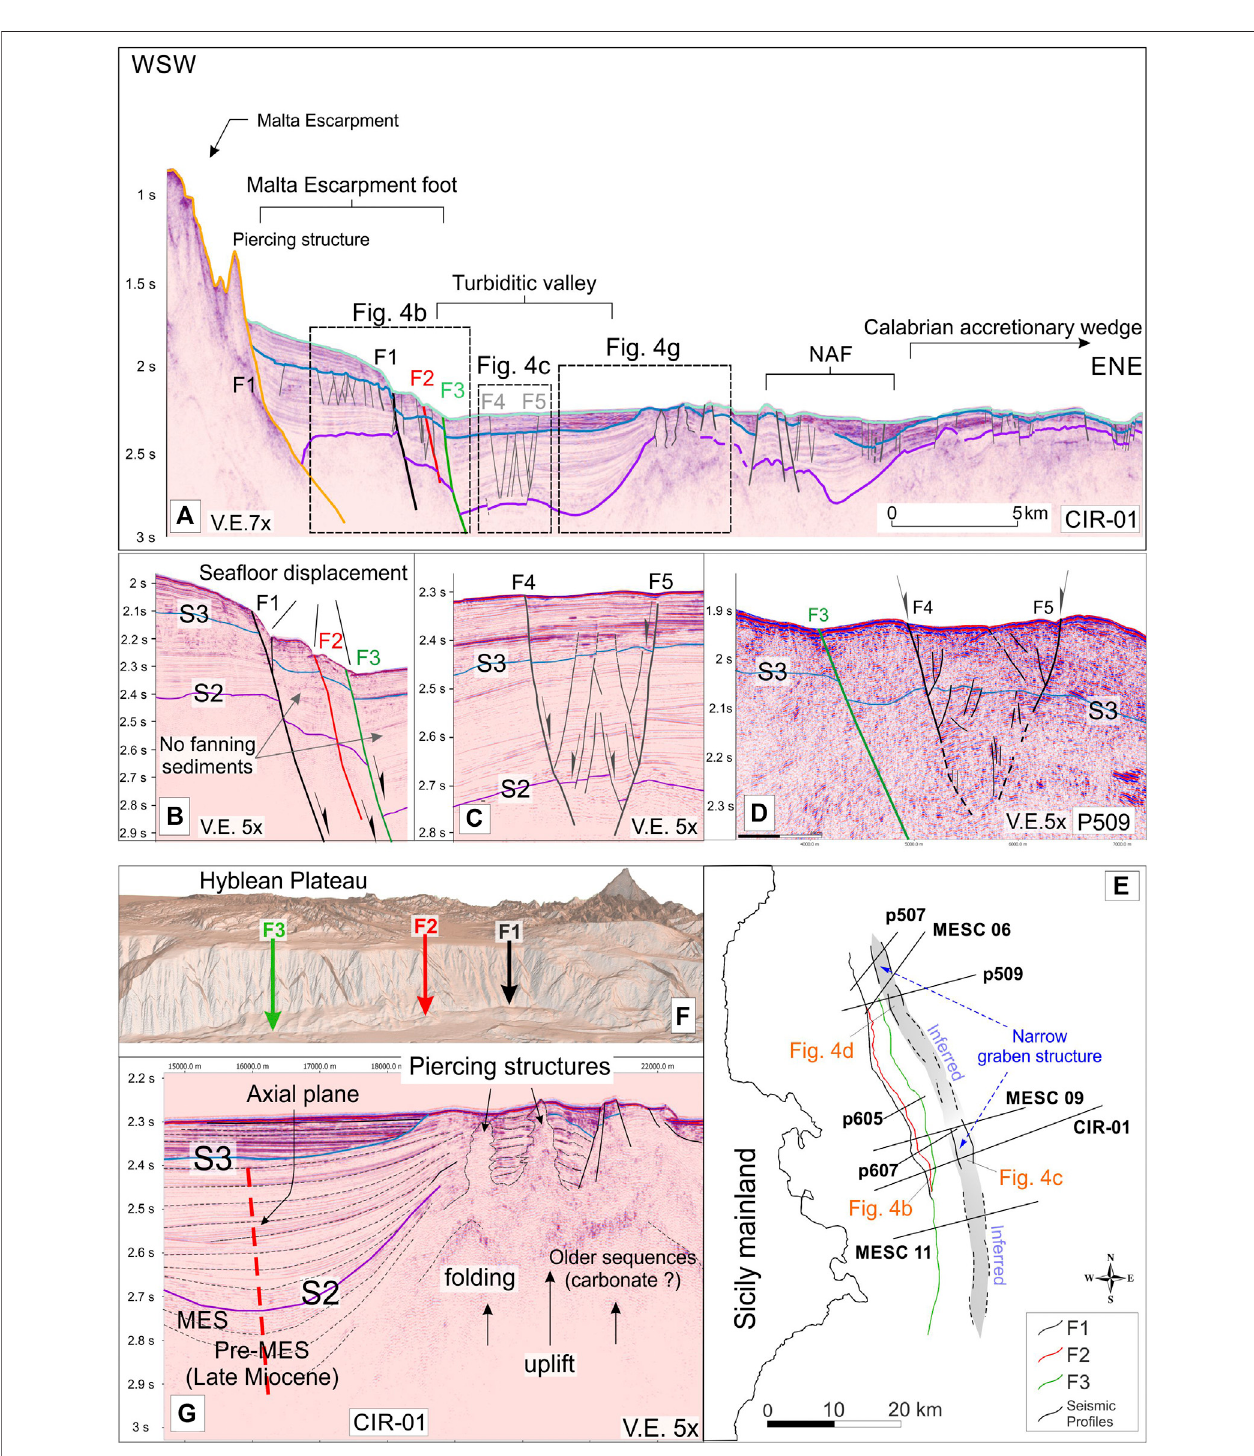
FIGURE 4 | (A) 3D perspective view of the interpreted seismic dataset. (B) Structural interpretation performed over the CIR-01 line showing the tectonic features occurringin the area. (C) Extensional E-dippingfaultsystem deforming thefoot of theMalta Escarpment and narrowgraben structure propagating through the turbiditic valley recognized along the CIR-01 (D) and P509 (E) seismic lines. Structural interpretation on the whole seismic dataset (see Supplementary Figure 2 ) allows to map accurately faults in the E-Sicily offshore (F) also following their bathymetric expression (G) . (H) Folded and diapirically pierced structure occurring in the western portion of the CIR-01 line and sediment pattern on its western limb.